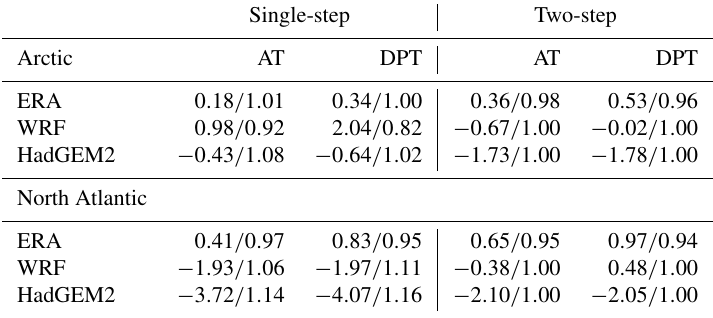
Table 1. Homogeneous single- and two-step calibrations of Arctic and North Atlantic 2m air temperature (AT) and dew point temperature (DPT) for 1979–2004. Shown are additive and multiplicative adjustments (left/right numbers) of the ERA reanalysis with reference to all ICOADS collocations in Fig. 1. Similarly, adjustments in WRF and HadGEM2 are with reference to ICOADS in the single-step calibration and with reference to the ERA time series in Fig. 2 (after adjustment) in the two-step calibration. The additive adjustment unit is ◦ C. Single-step Two-step Arctic AT DPT